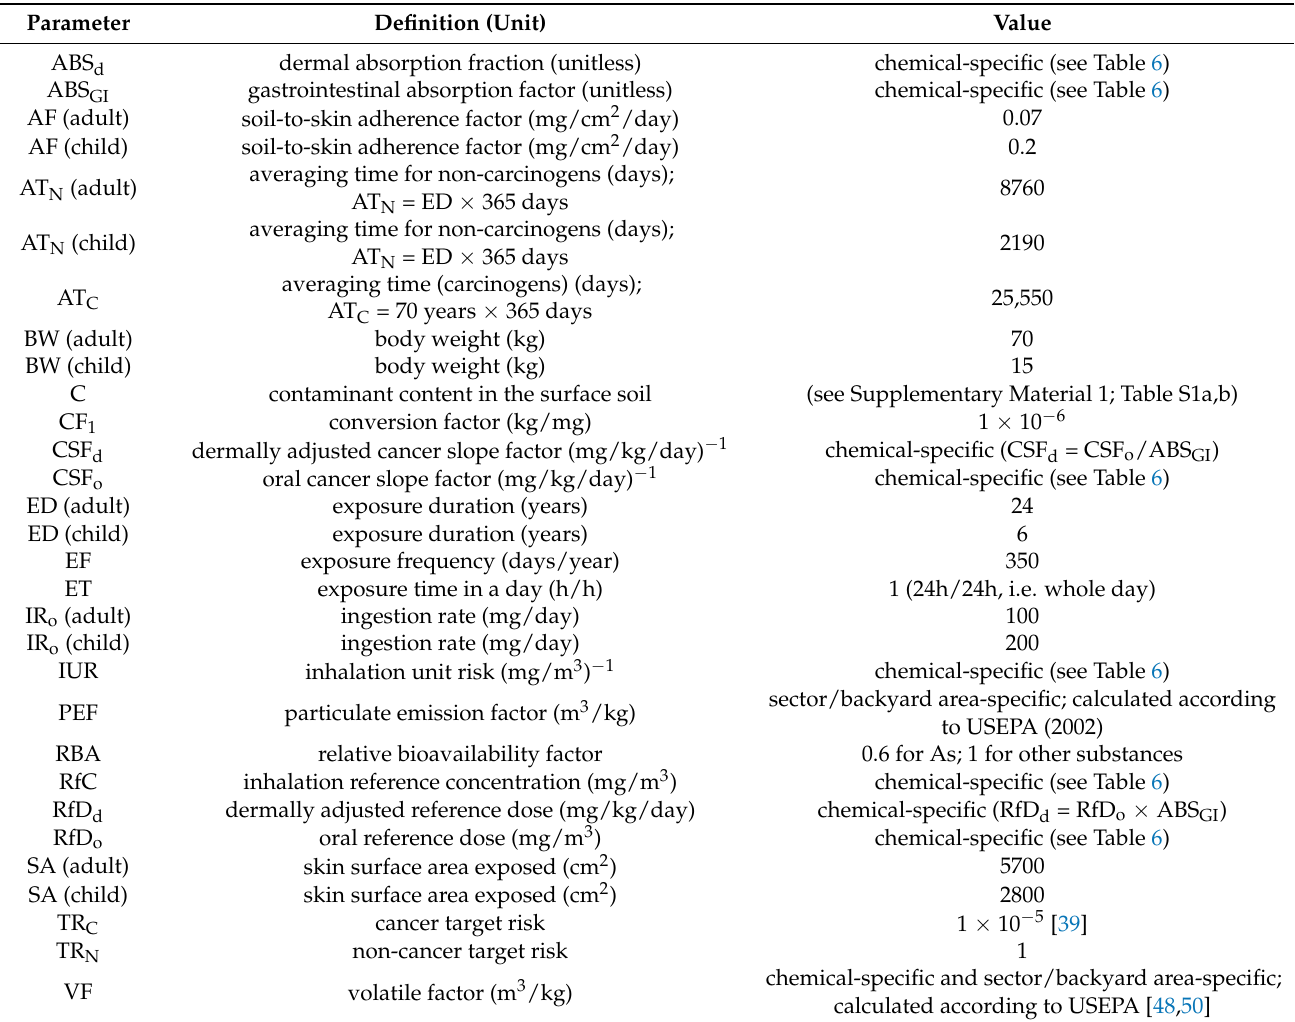
Table 5. Parameter values applied for health risk assessment in ŁWS